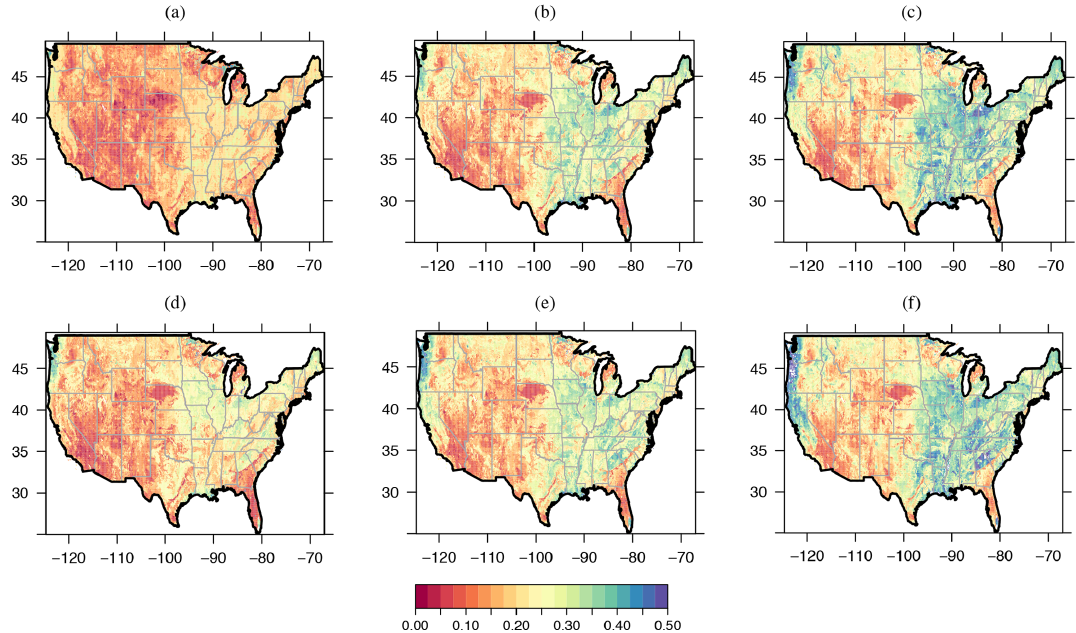
Figure 3. Same as shown in Fig. 2, but for SPL4SMAU (root-zone soil